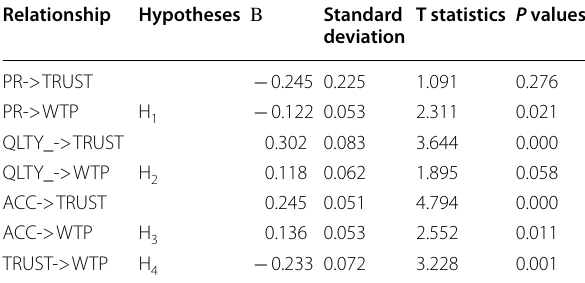
Table 4 Total effects